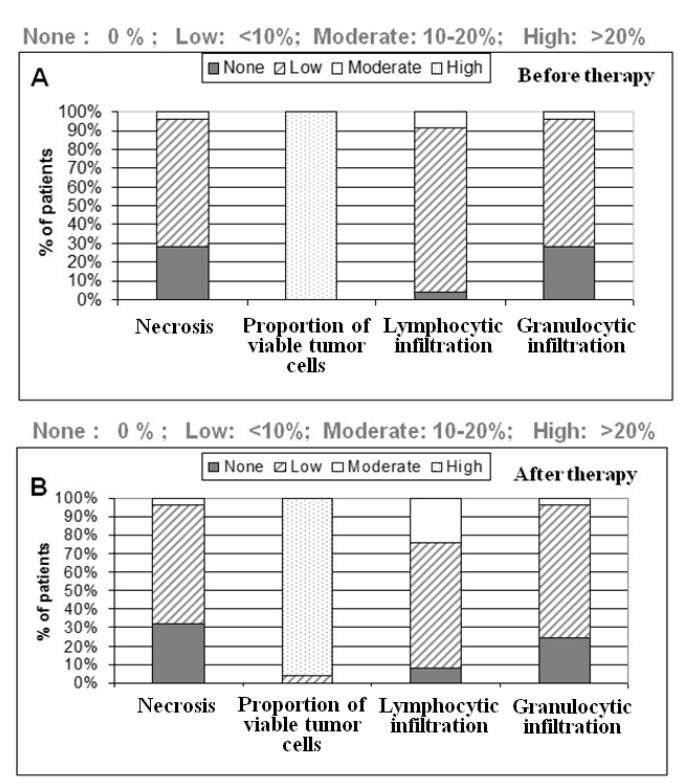
Figure 5. Histomorphological Characterization. ( A ) Samples (n = 50) at stage of diagnosis and ( B ) after neoadjuvant radiochemotherapy, used for further analytical purposes. Most samples contain a large number of viable tumor cells and only a low to moderate percentage of necrosis, lymphocytic and granulocytic